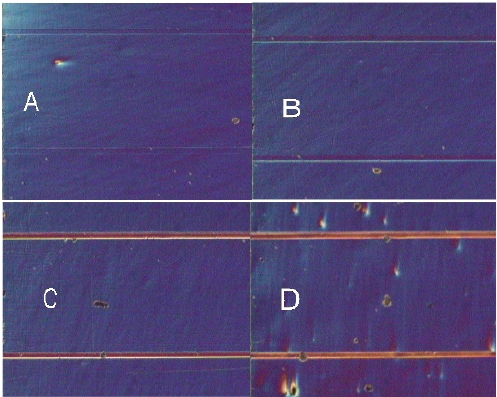
Figure 4. Polarisation microscopic photos of channel waveguides implanted through a silicon mask using 1.5 MeV N + ions at fluences of 0.5, 1, 2 and 4 · 10 16 ions/cm 2 ( A – D ). Width of the channel waveguides is 25 μ m.